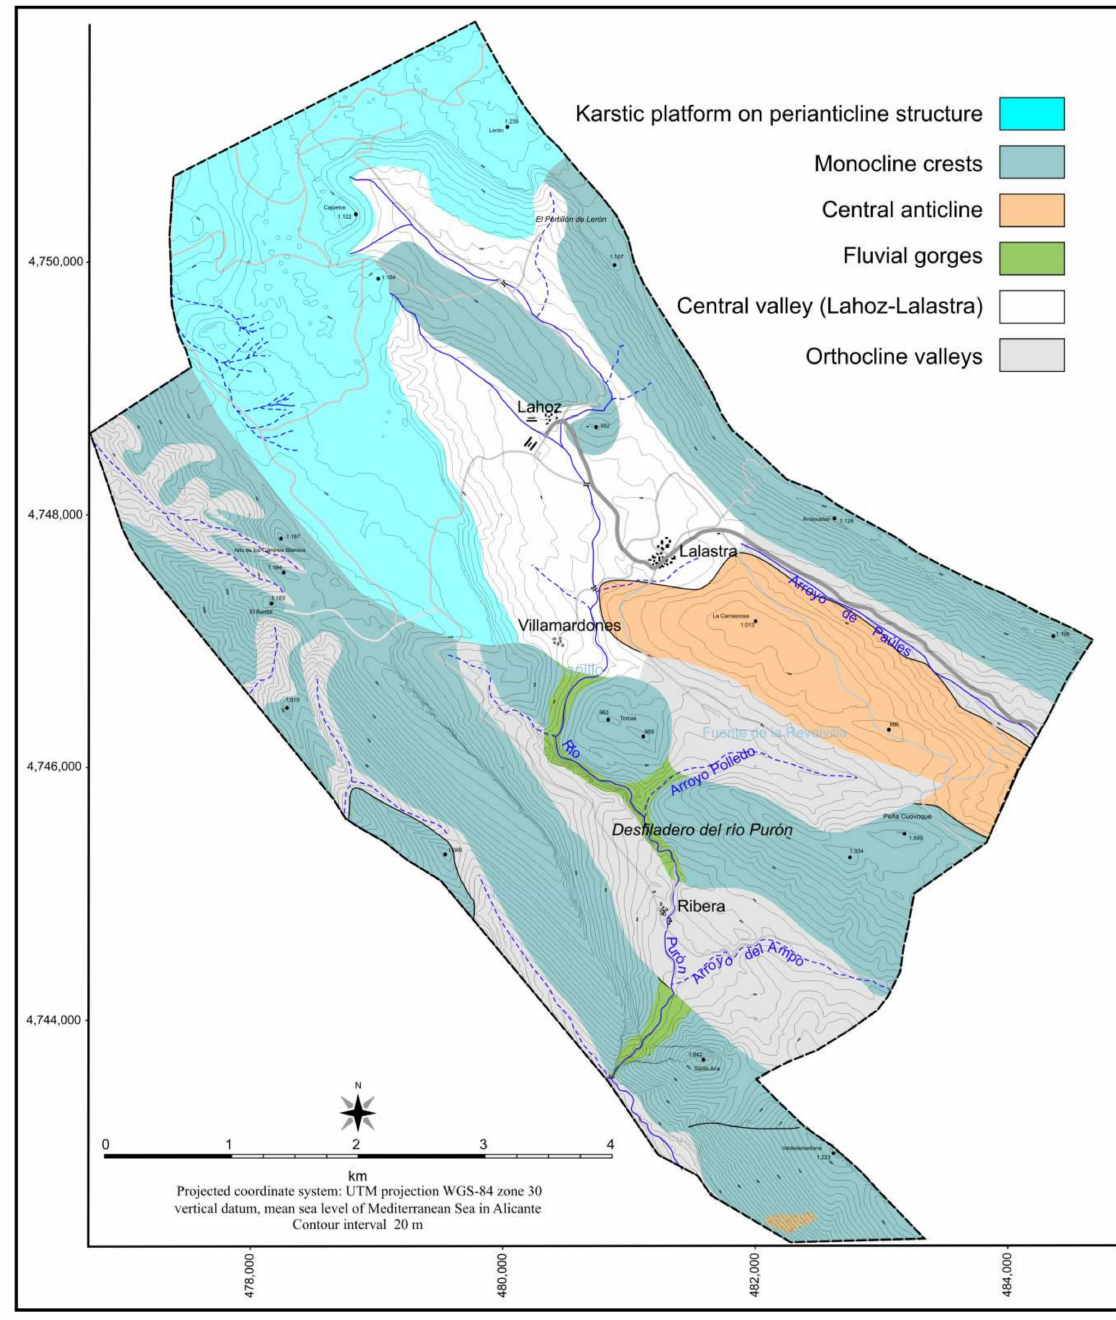
Figure 7. Valderejo Natural Park. Geomorphological